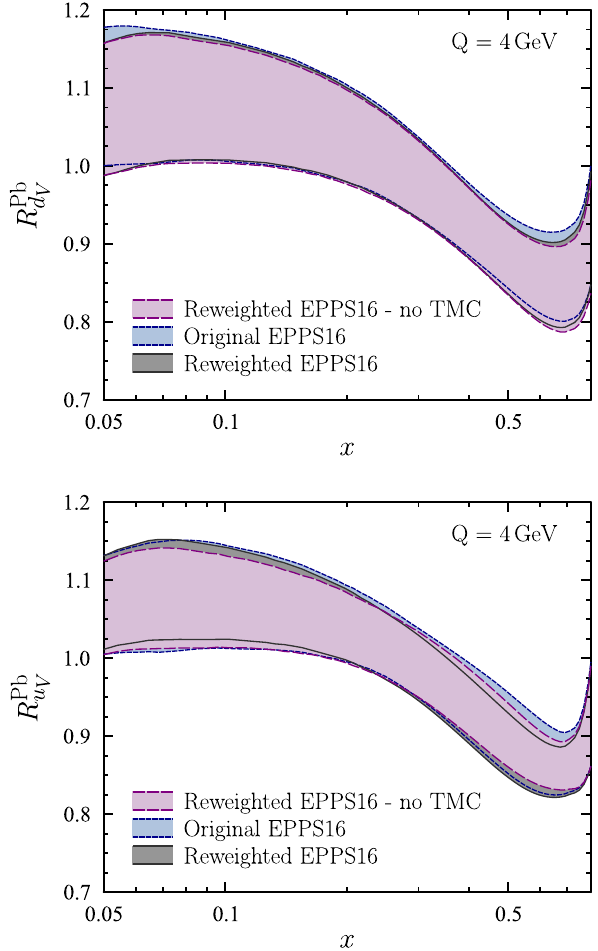
Fig. 6 Effect of re-weighting on EPPS16 with and without the TMCs